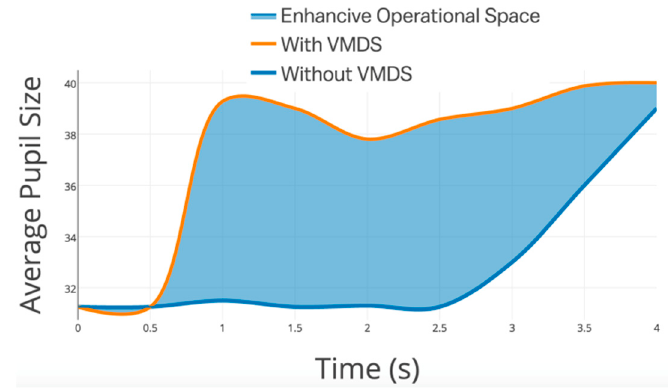
Figure 22. Average pupil size change with time.